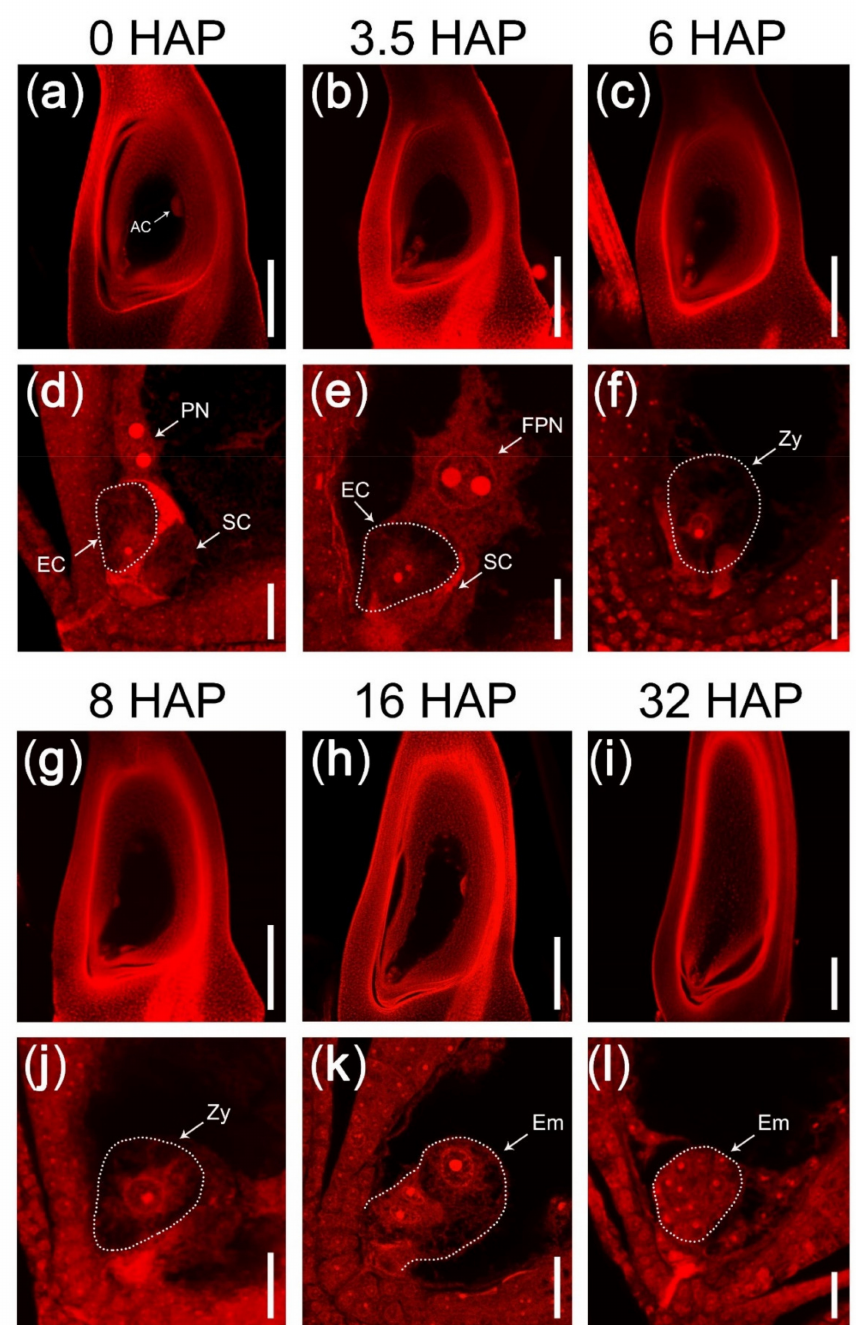
Figure 1. Double fertilization process in rice. ( a , d ) A mature embryo sac containing one egg cell (EC), two synergid cells (SC), one central cell with two polar nuclei (PN), and a group of antipodal cells (AC). ( b , e ) An embryo sac at 3.5 HAP. The two polar nuclei were fusing and two nucleoli were unfused. ( c , f ) A zygote (fertilized egg cell) at 6 HAP. ( g , j ) Double fertilization have completed at 8 HAP. ( h , k ) The zygote was activated and began to divide at 16 HAP. ( i , l ) An early globular embryo with over ten cells at 32 HAP. ( a – c , g – i ) CLSM photos of ovaries stained with eosin B at 10 × lens magnification. ( d – f , j – l ) The micropylar part of embryo sacs in ( a – c , g – i ) at 63 × lens magnification. The dotted lines indicated the egg cell, the zygote, or embryo. AC, antipodal cell; PN, polar nuclei; FPN, fertilizing polar nuclei; EC, egg cell; SC, synergid cell; Zy, zygote; Em, embryo. Scale bars = 200 µ m in ( a – c , g – i ); 20 µ m in ( d – f , j – l